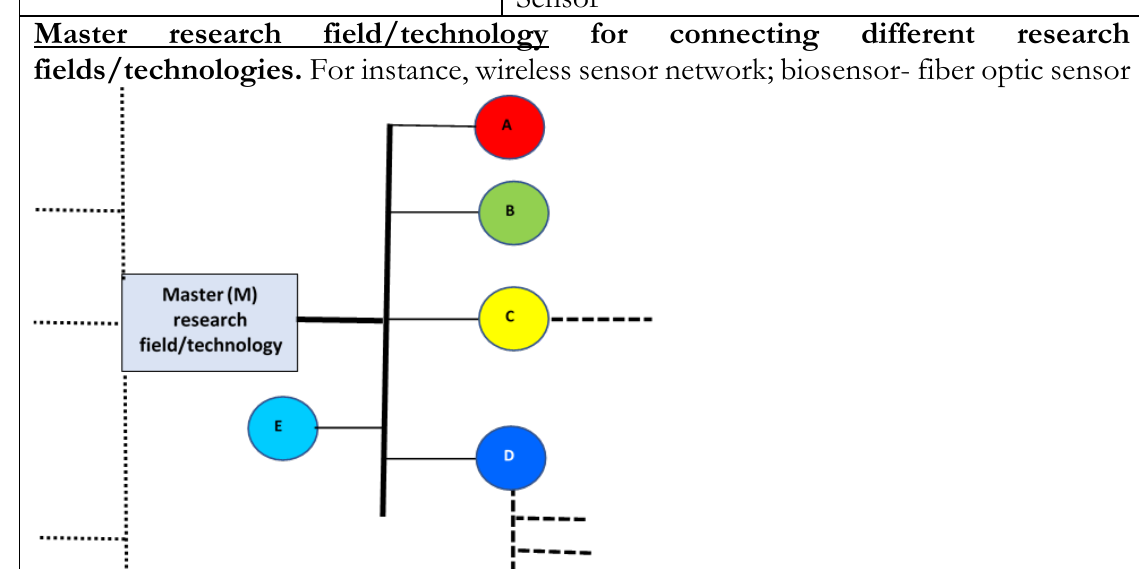
Figure 2. Patterns of evolution of science and technology based on characteristics of networks. Note : Capital letters (e.g., A, B, . . . , E) in small circumferences of figures above (using terminology of set theory) indicate research fields or technologies.